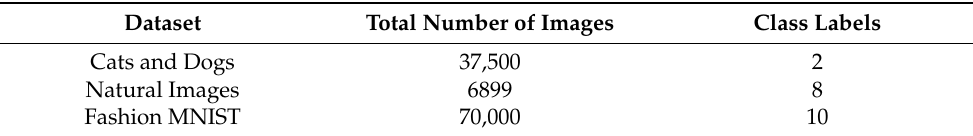
Table 3. Summary of the image classification